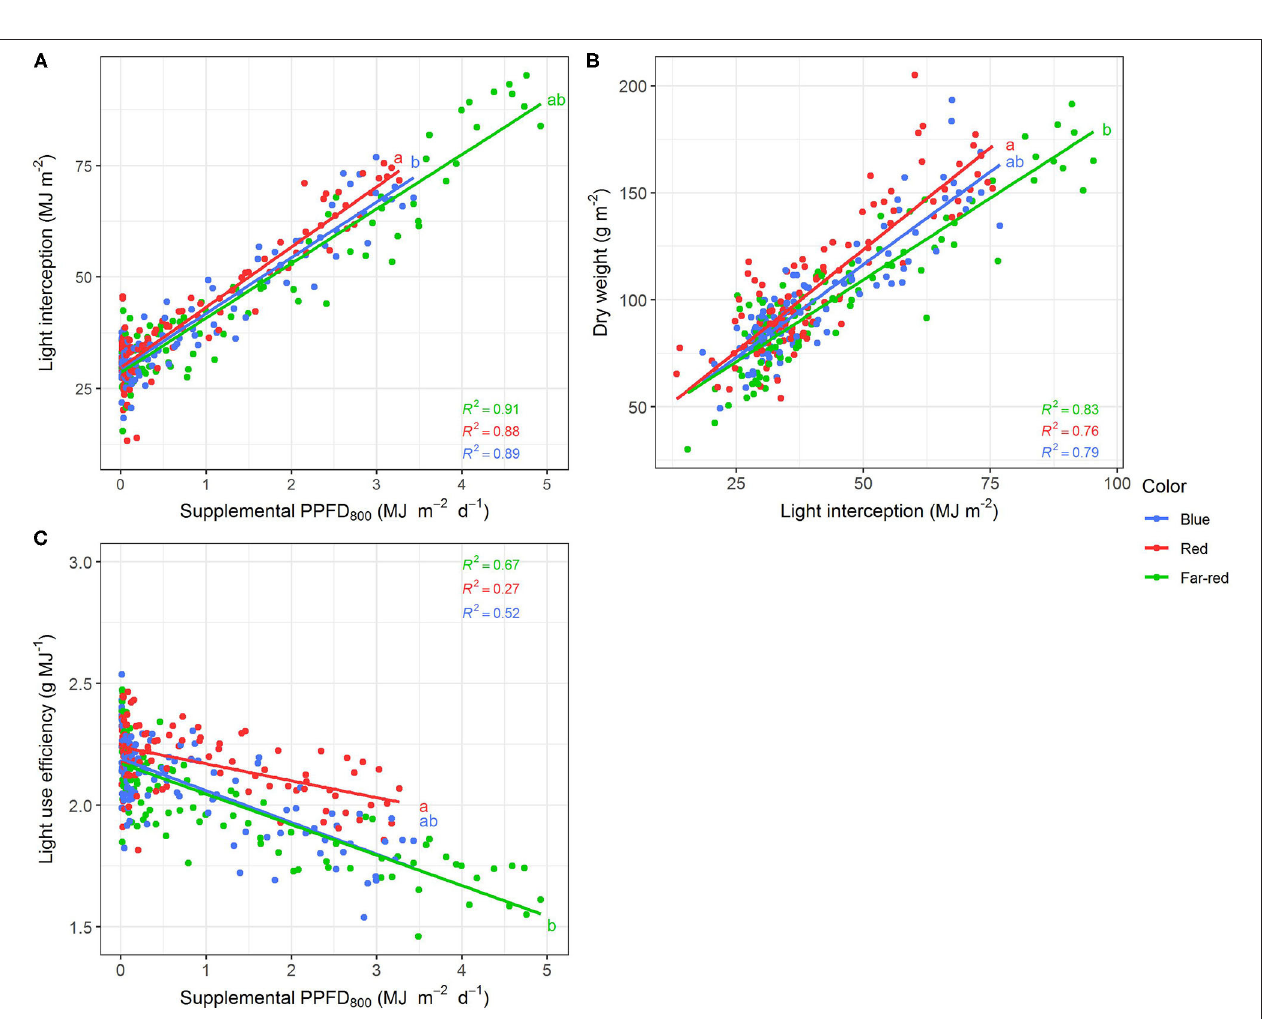
FIGURE 7 | lower-case letters indicate significant differences in slopes between colors ( p < 0.05). Linear or monomolecular regression lines of each light color are indicated. Regressions are based on 120 plants per treatment, each with a specific light dose. Each data point shows an average of the four seasons, two harvest points and two experimental repetitions.